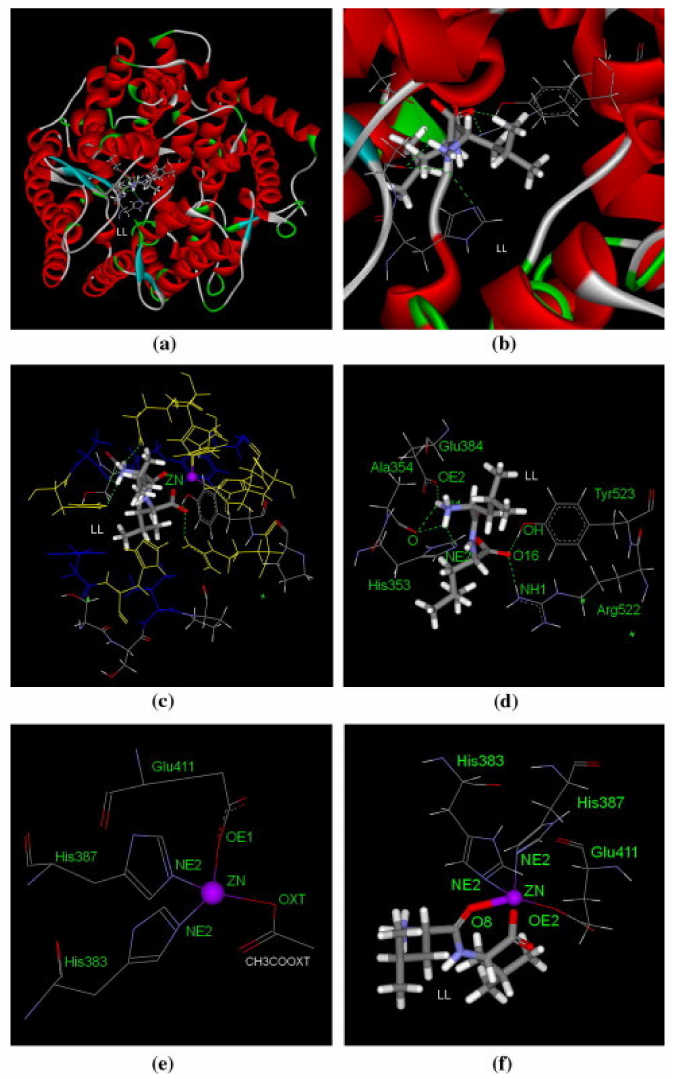
Figure 3. General overview of peptides (LL) interaction with ACE. ( a ) ACE structure and its best docking poses (grey) at the active site, ( b ) regional view of the best docking poses at the active site, ( c ) ACE-LL interaction view at the catalytic site (see the zinc ion in the center of the interactions), ( d ) the best docking poses of LL (grey) at the active site, ( e ) tetrahedrally coordinated zinc ion with the ACE residues before docking, and ( f ) interactions between LL and zinc ion at the ACE active site after docking. ACE hydrophobic and hydrophilic residues are represented in blue and yellow, respectively. Other residues on active site in grey, and zinc atoms in purple. Green dashed lines and grey bold lines represent the hydrogen bonds and zinc coordination bonds, respectively. Reproduced from Pan, Guo, Zhao, and Cao [123] with permission from Elsevier